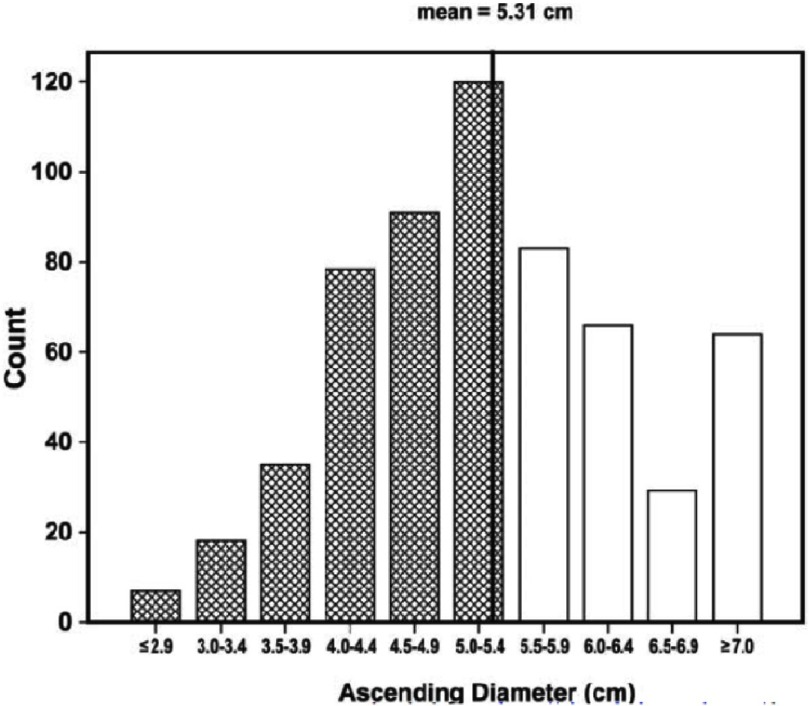
Distribution of aortic diameter (cm) at time of presentation with type A AAD.Shared bars indicate 59% of patients with diameter < 5.5 cm. Reproduced with permission of Pape LA et al. Circulation. 2007 Sep 4;116(10):1120-7.